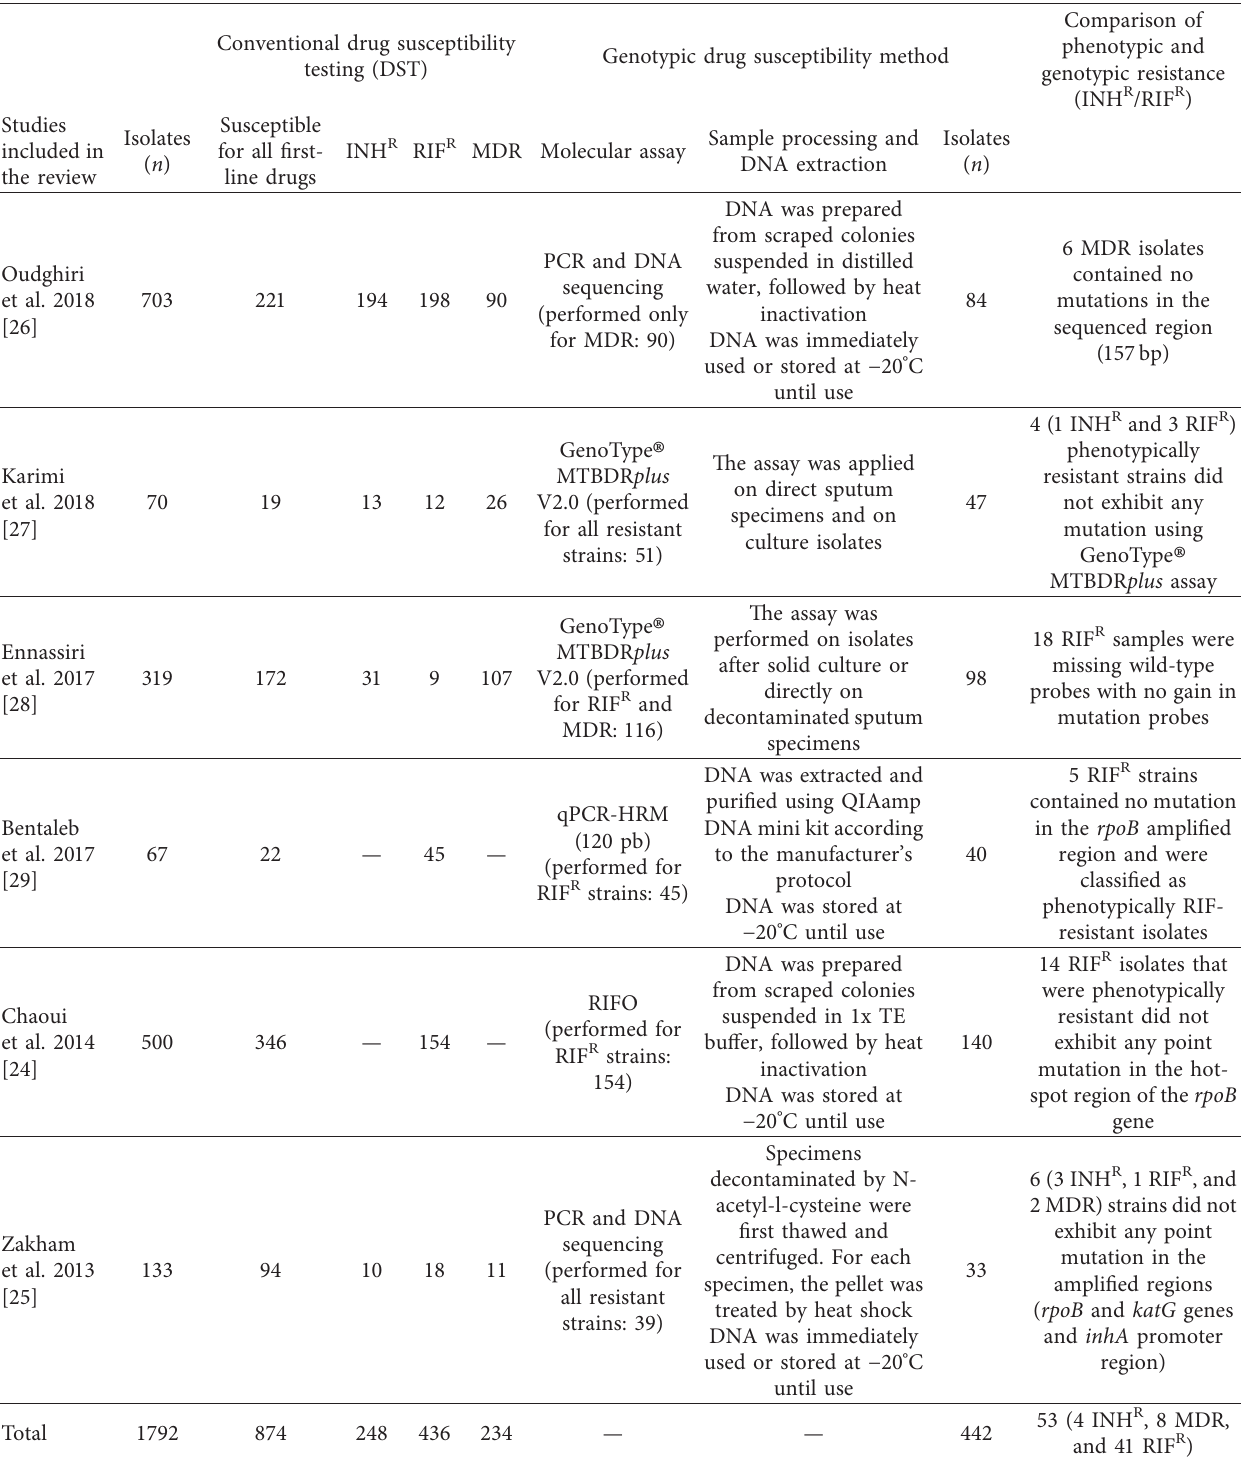
Table 2: Phenotypic and genotypic drug susceptibility